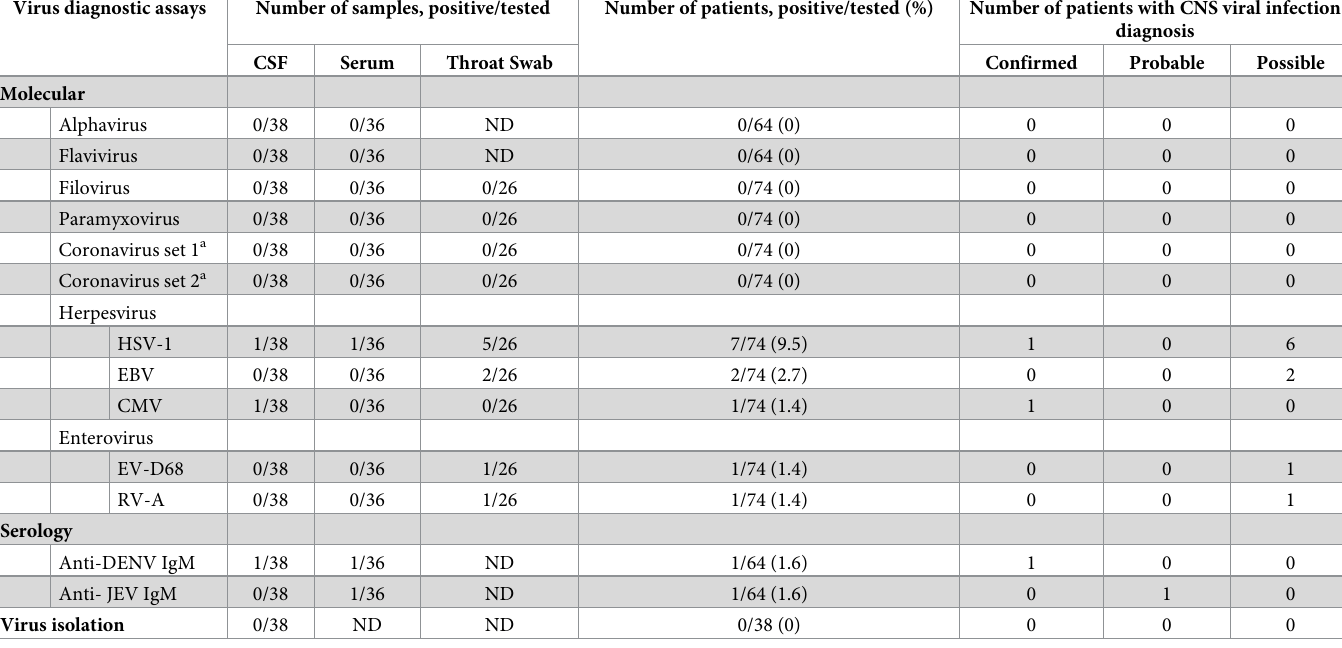
Table 2. Viral diagnostic assays and detection from adult patients with suspected CNS infection. Virus diagnostic assays Number of samples,